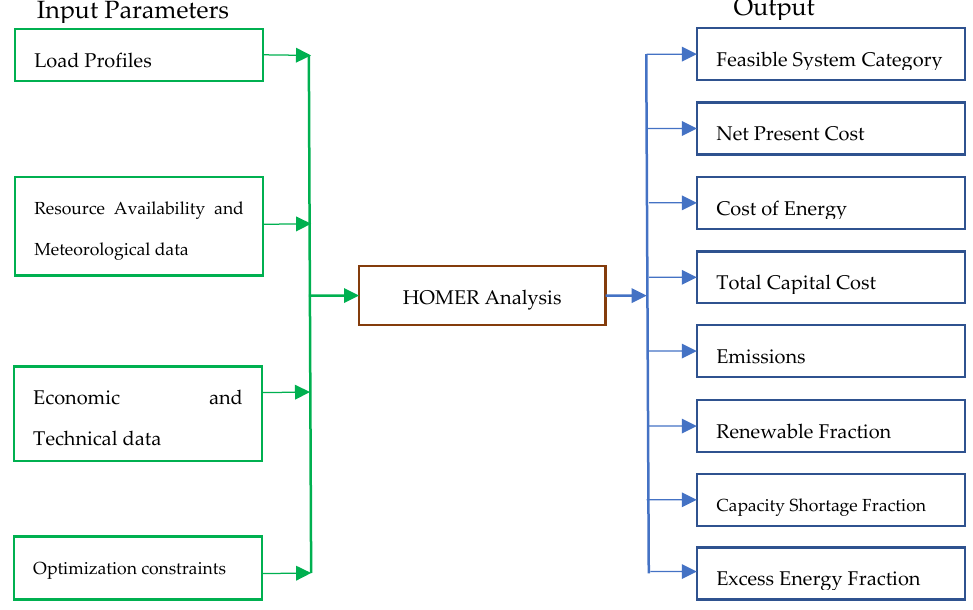
Figure 1. HOMER Pro analysis architecture diagram.